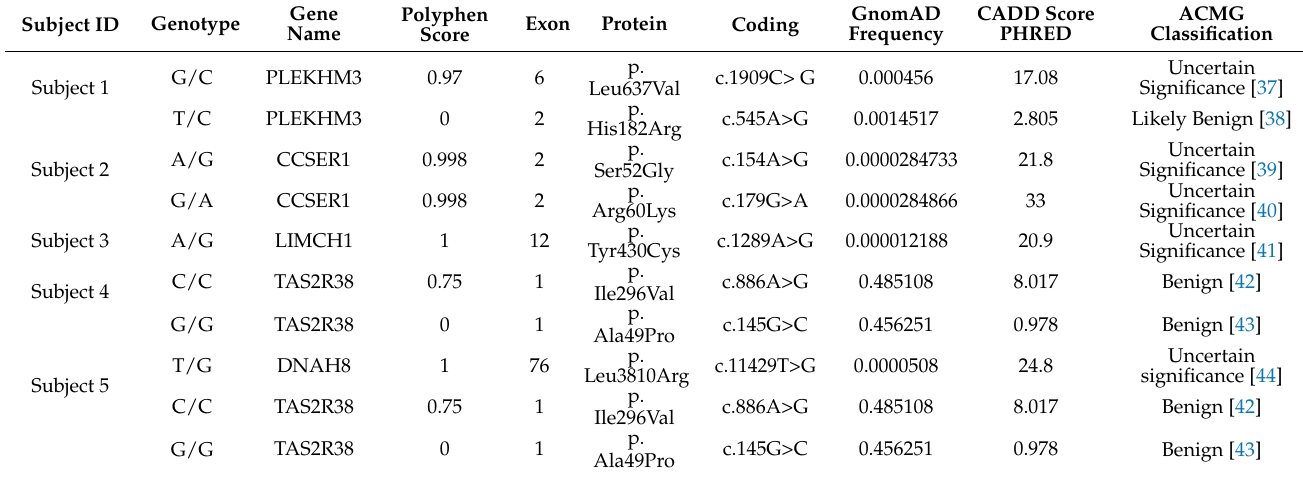
Table 4. Variants identified after WES and The American College of Medical Genetics and Genomics (ACMG) classification terminology. CADD PHRED is scaled Combined Annotation Dependent Depletion score. GnomAD Frequency is the variant allele frequency in